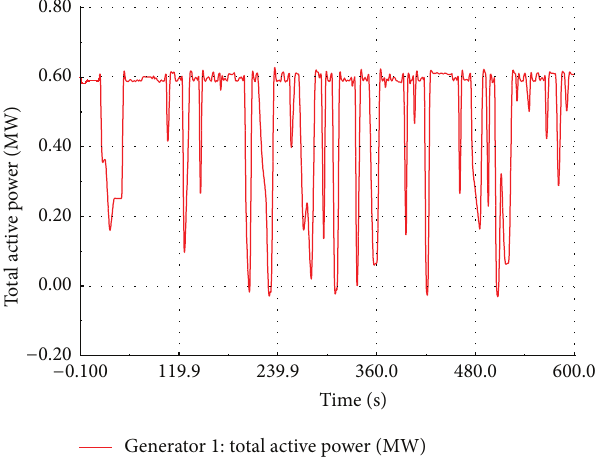
Figure 10: Simulated real power at FSWEG1.